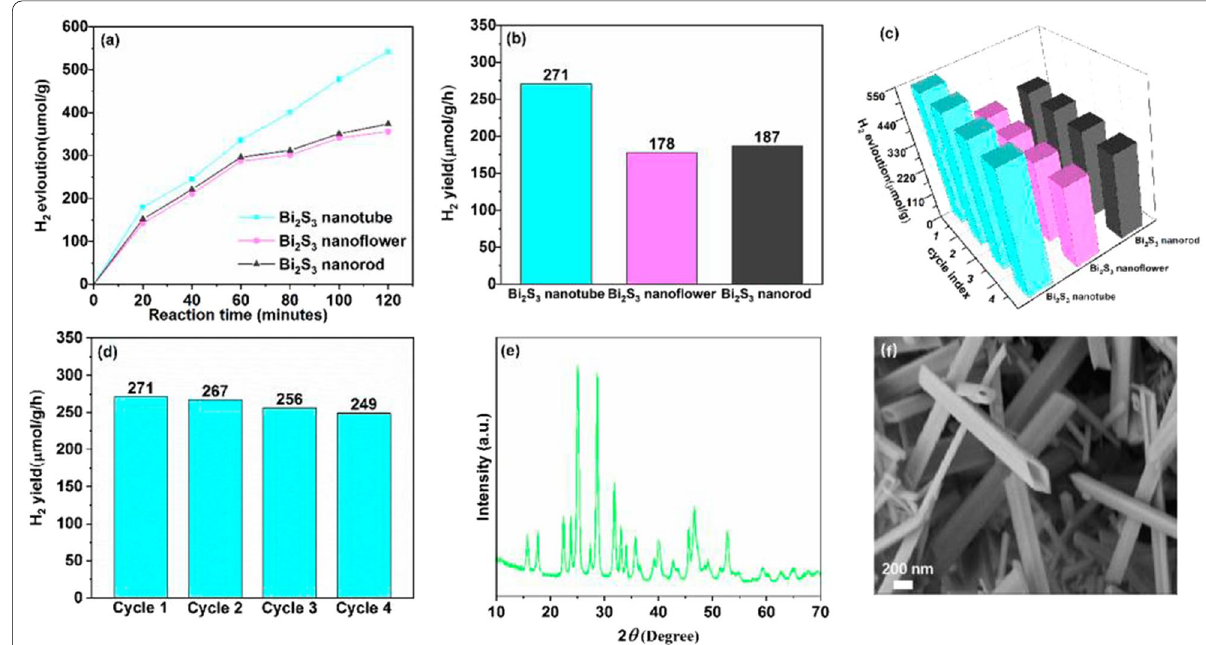
Fig. 6 a Photocatalytic H 2 evolution, b H 2 yield and c recycling test of the Bi 2 S 3 nanotubes, nanoflowers and nanorods in a mixed aqueous solution containing